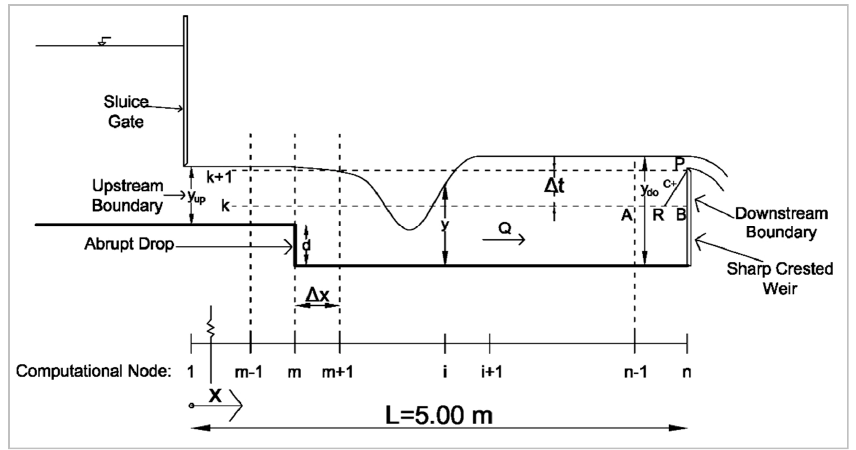
Figure A1. Physical and computational domain of the rapidly varied flow in the region of the drop. The Boussinesq equations can be solved numerically using two different schemes, the Dissipative Two-Four and the MacCormack scheme. The Dissipative Two-Four scheme consists of a predictor and a corrector step, again for the spatial derivatives of Equation (7), in the predictor step forward finite differences are used and in the corrector step backward finite differences. This scheme includes the spatial nodes i + 2, i + 1 and i in the predictor step (Equation (A1)) and the nodes i, i − 1 and i − 2 in the corrector step (Equation (A2)) respectively, as: G (cid:2919)∗ = G (cid:2919)(cid:2921) + λ 6(cid:3435)F (cid:2919)(cid:2878)(cid:2870)(cid:2921) − 8F (cid:2919)(cid:2878)(cid:2869)(cid:2921) + 7F (cid:2919)(cid:2921) (cid:3439) + ΔtS (cid:2919)(cid:2921) ,